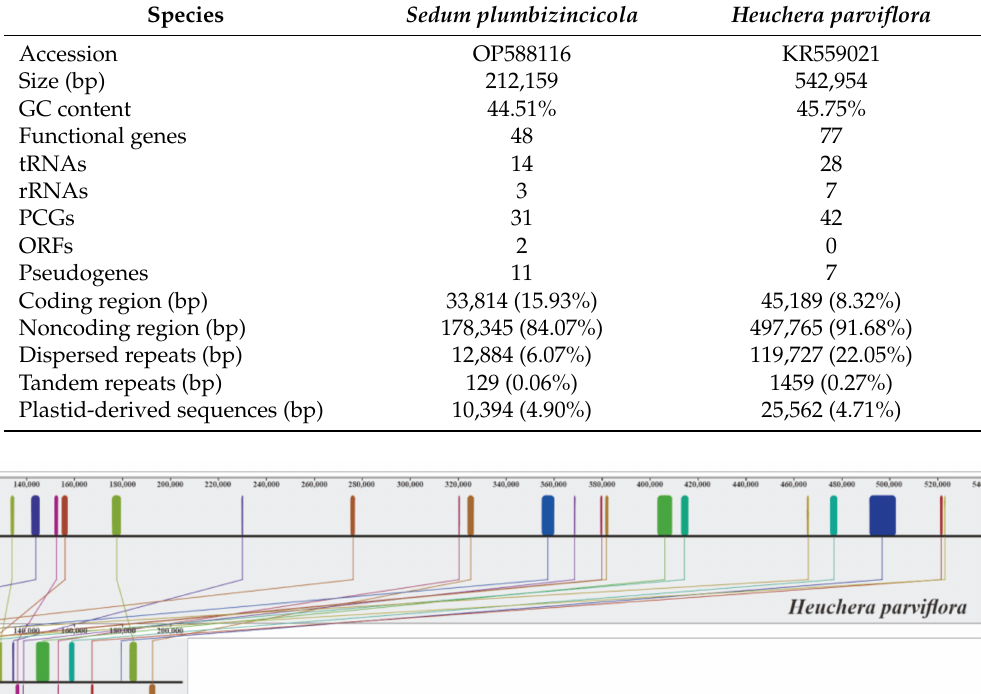
Table 1. Comparisons of general features of mitogenomes between S. plumbizincicola and H. parviflora . Species Sedum plumbizincicola